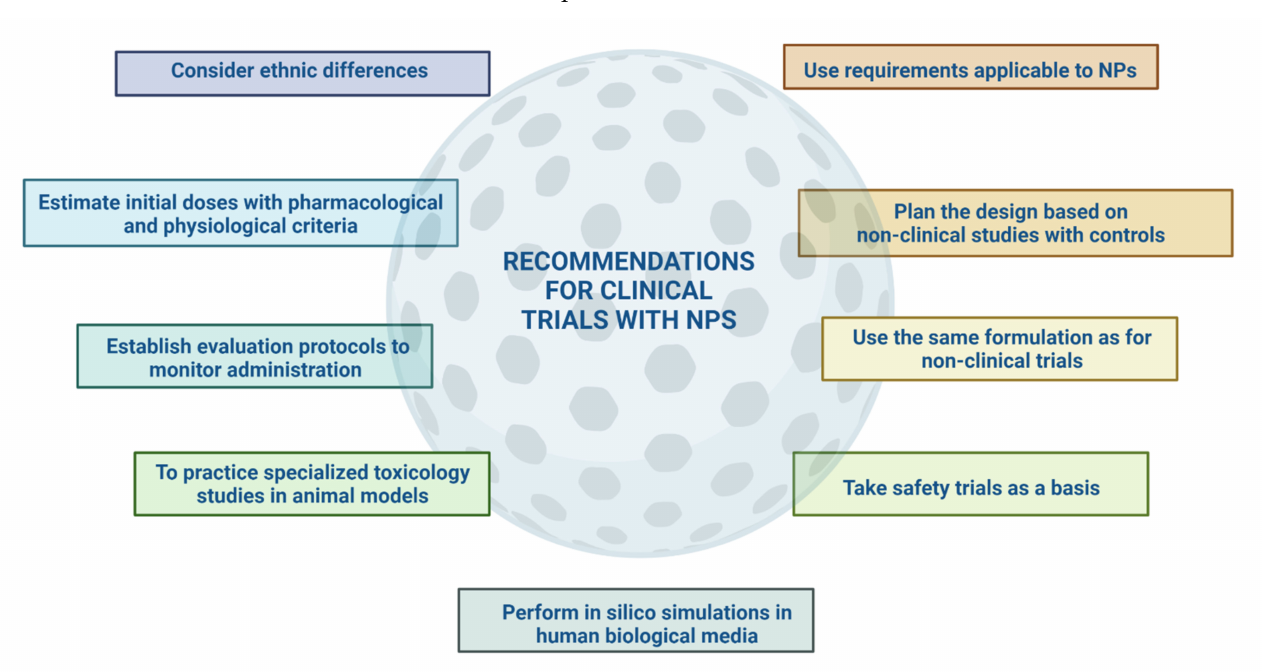
Figure 11. Recommendations for evaluating NPs for clinical trials. Created with BioRender.com (accessed on 10 December